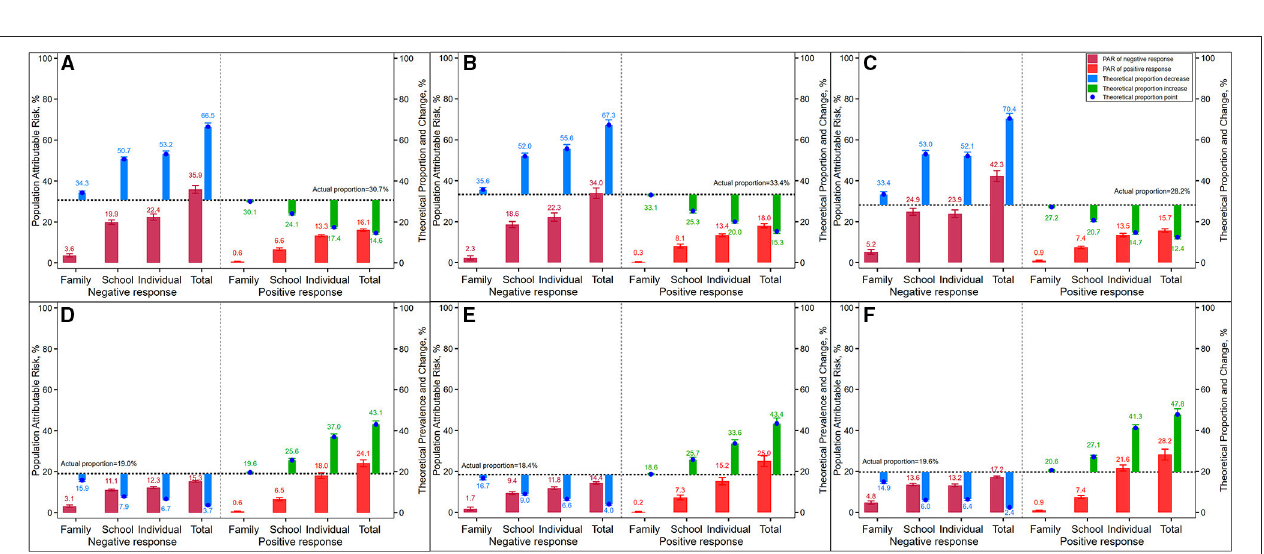
FIGURE 4 | Comparison of the association strengths between high PFI and ecological correlates at an individual, family, or school level. The ORs assessing the associations between high-PFI levels (dependent outcome variables), and ecological correlates (independent variables) were calculated with adjustment for age, sex, area, province, and regional-level SES.